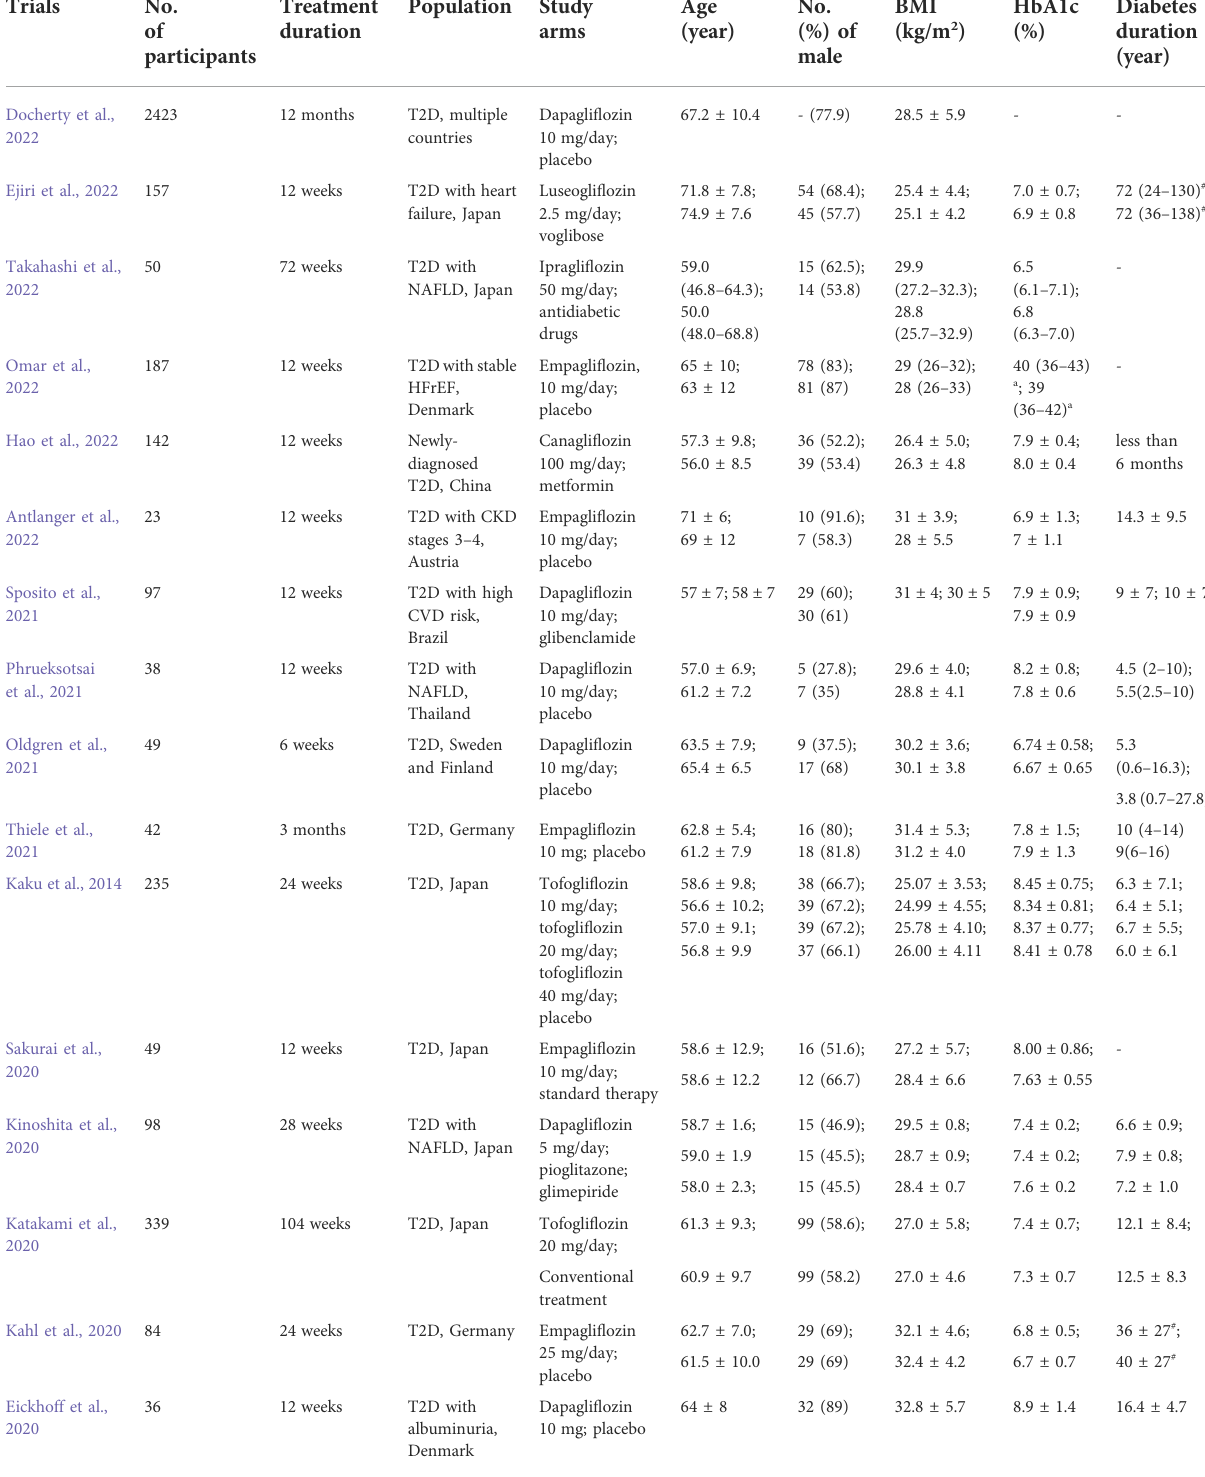
TABLE 1 Main characteristics of patients included in the meta-analysis.